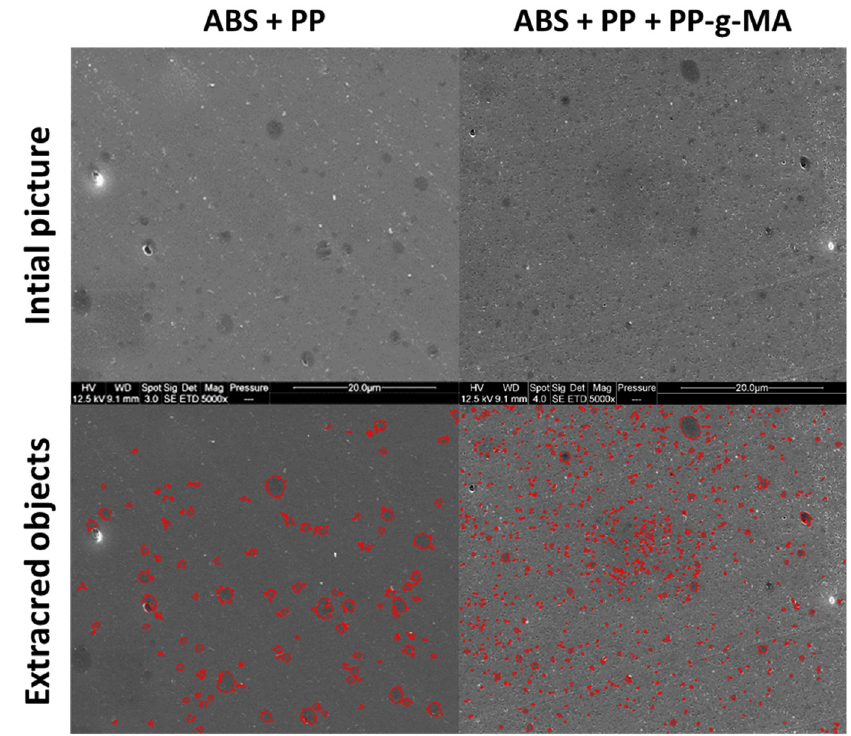
Figure 9. Binarization of SEM micrographs of cuts performed using an ultracyromicrotome—ABS + PP and ABS + PP + PP-g-MA systems.